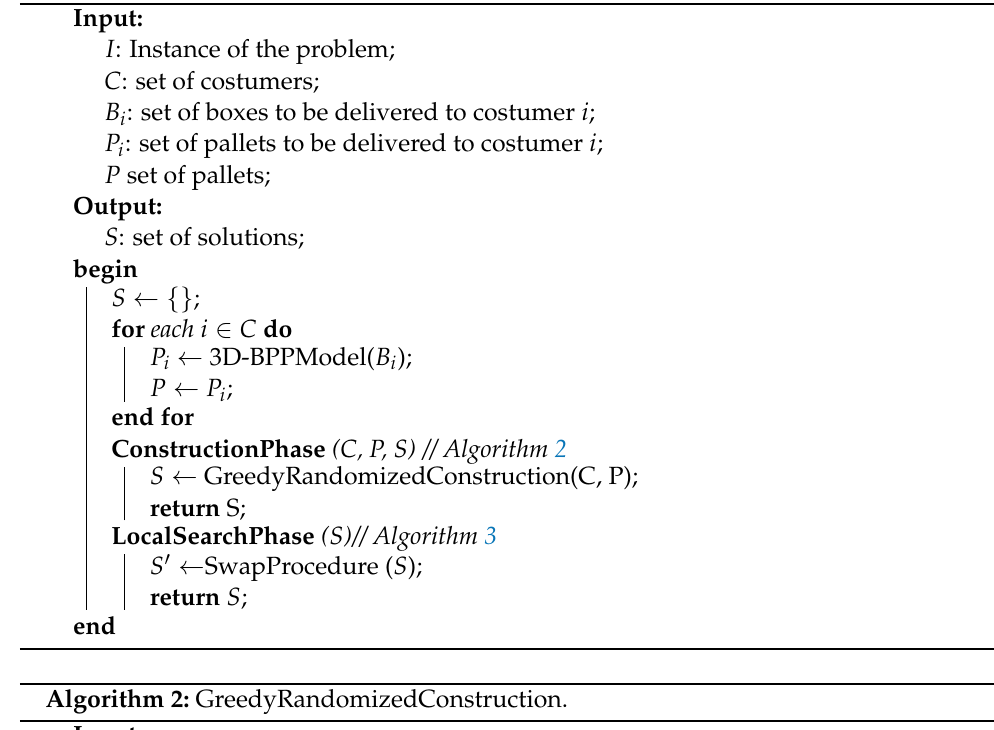
Algorithm 1: Hybrid Algorithm.